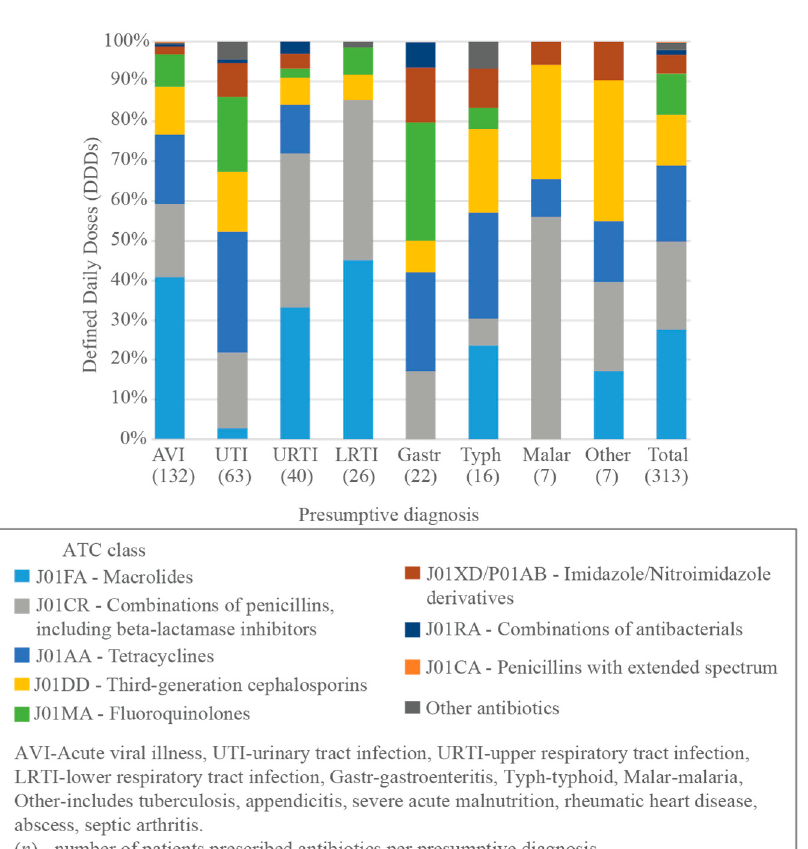
Figure 4. Distribution of antibiotic prescription during the outpatient visit by presumptive diagnosis, according to WHO ATC classification in percentage of total Defined Daily Doses (DDDs).